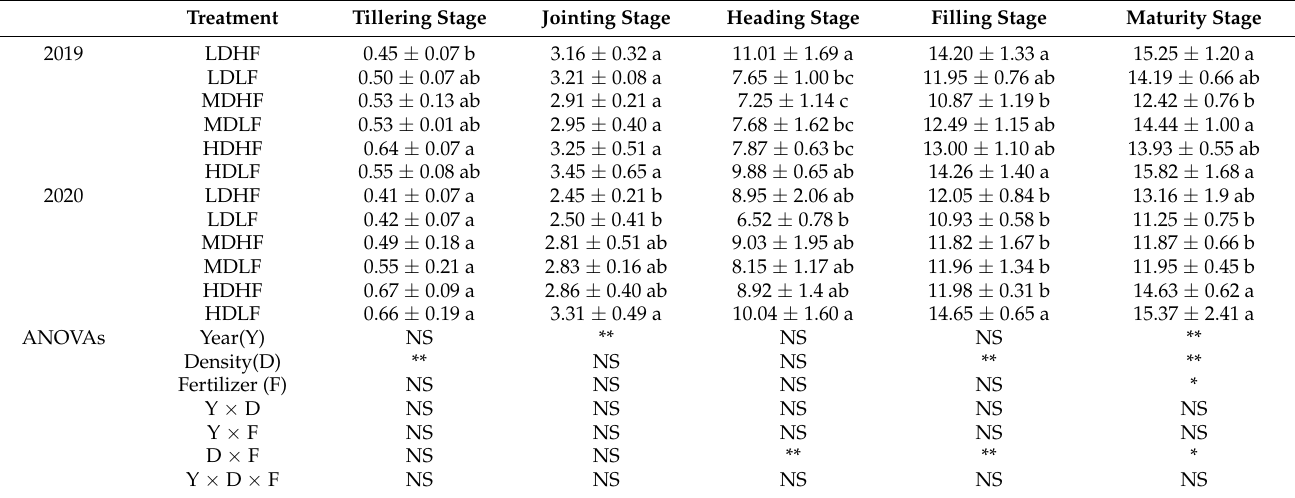
Table 5. Aboveground dry matter weight in different growth stages of rice under different